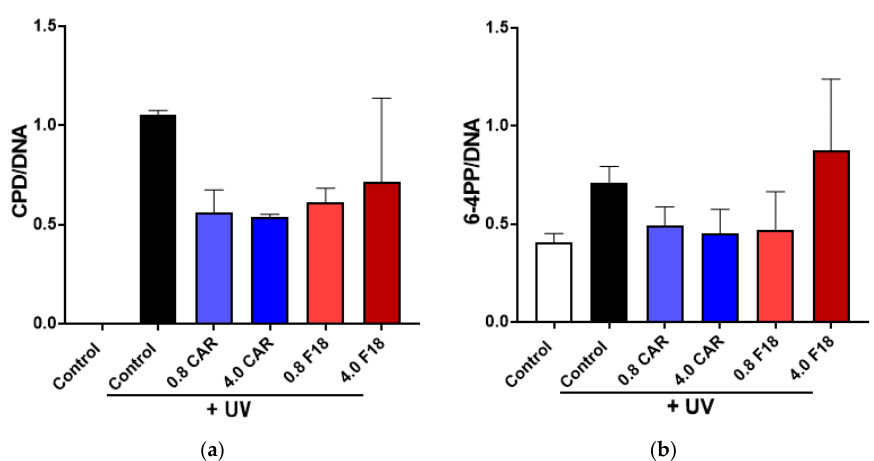
Figure 7. Effects of F18 on UV-induced CPD ( a ) and 6-4PP formation ( b ) in 3D human reconstituted skin. The skin was treated with UV radiation (300 mJ/cm 2 ) with or without free carvedilol (CAR) or F18 in two doses for 24 h. Genomic DNA was isolated from the skin and analyzed with slot blot assays. Quantified and normalized CPD and 6-4PP values are expressed as mean + SE ( n = 3). As expected, UV radiation also upregulated the expression of proinflammatory biomarkers including IL-1 β , TNF- α , and COX-2, as detected by qRT-PCR (Figure 8). The qRT-PCR assay showed that F18 was able to attenuate these proinflammatory genes to a similar degree as carvedilol in acetone. Similar to the CPD/6-4PP assays, the inhibitory effects of F18 as well as the free drug were not dose dependent.